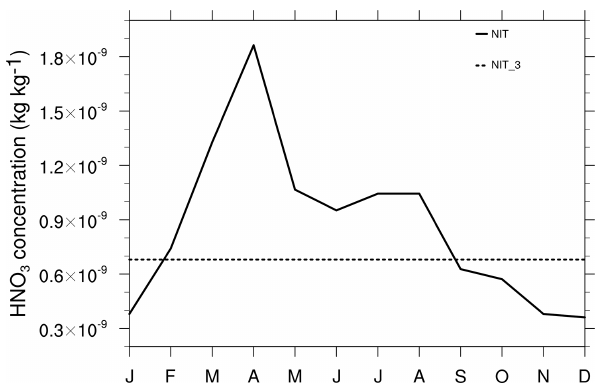
Figure 3. 2003–2007 monthly mean of HNO 3 surface concentra- tion over Europe (as defined in Fig.